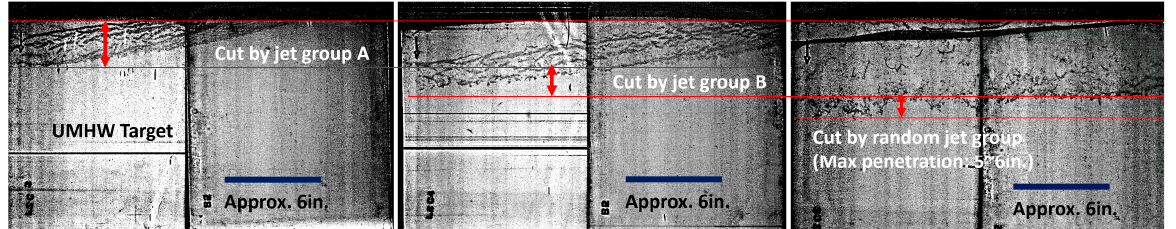
Figure 2. Flash X-ray images of 2000 g/ft LSCs penetrating UHMW targets. The LSC is located above the frame, and is not shown. From left to right, 75, 105, and 165 µs after initiation. The detonation front moves from left to right in each image. White area is UHMW, and particulated LSC jets (black- colored segments in upper middle) are moving downward, penetrating the UHMW target.